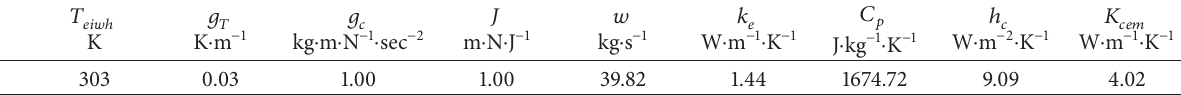
Table 3: The values of the thermophysical properties for the calculation of temperature profile.